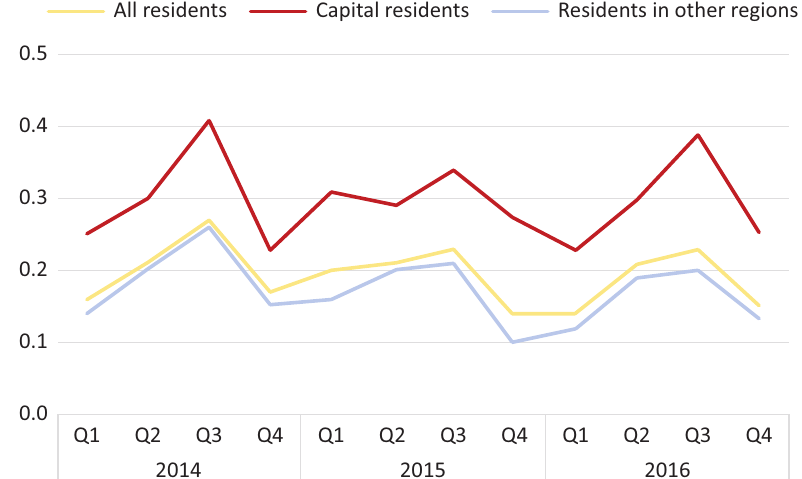
Figure 1. Evolution over time, average number of holiday flights per person and quarter. Source: Statistics Austria (2017) and own